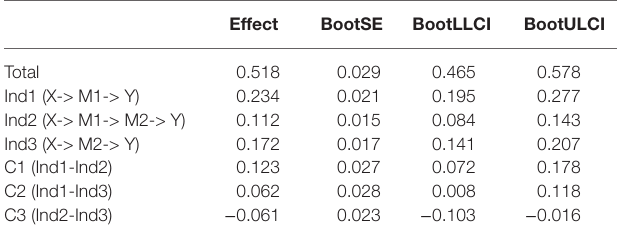
TABLE 5 | Indirect effect results of mediation